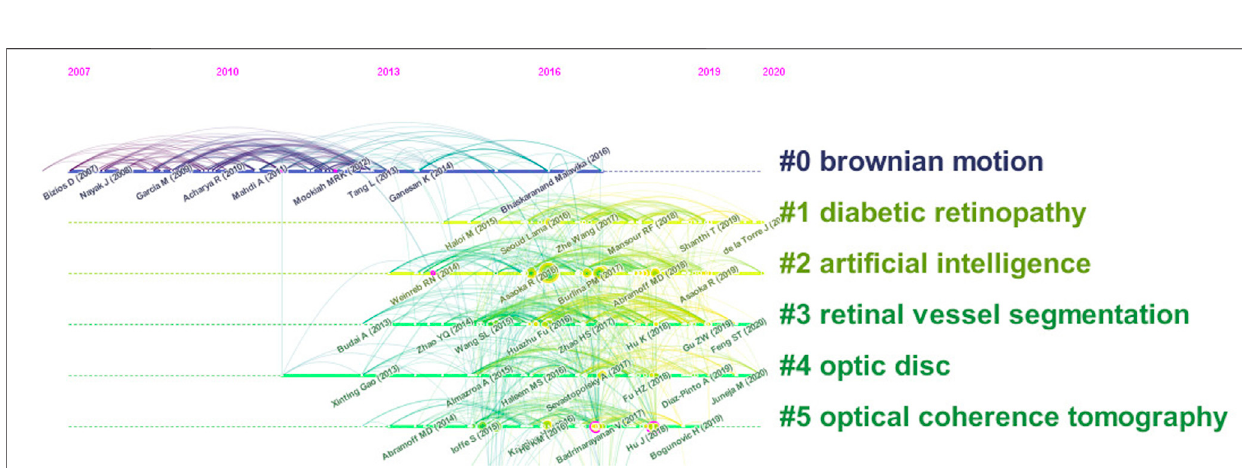
Frontiers in Pharmacology |